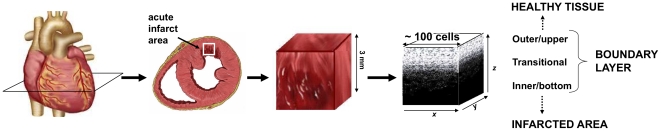
We consider excitation dynamics on a microscopic spatial scale, in areas of cardiac tissue with severely suppressed cell-to-cell coupling superimposed with elevated cell excitability.